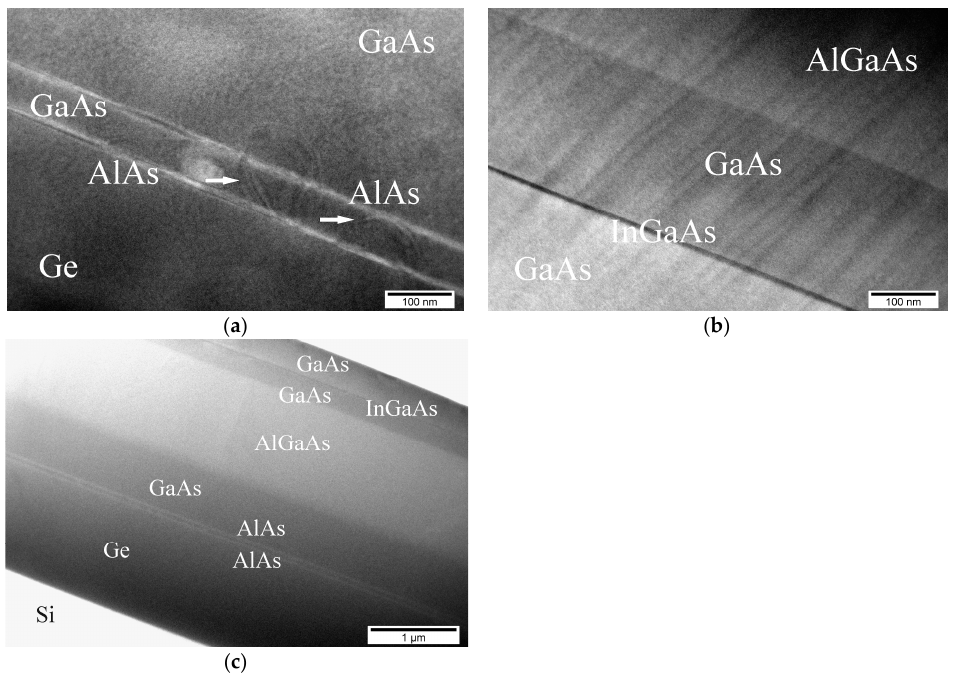
Figure 8. TEM images of the cross section of the laser heterostructure G: ( a ) Heterointerface with AlAs/GaAs/AlAs layers, ( b ) active region with InGaAs/GaAs QWs, ( c ) cross-section of the entire heterostructure. The white arrows indicate defects.